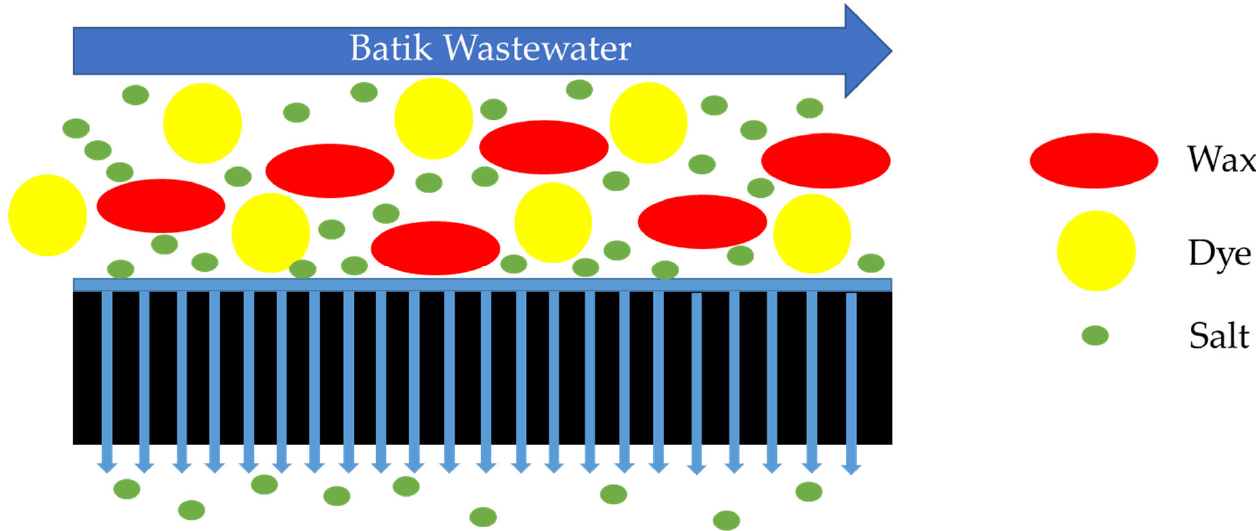
Figure 3. Illustration of contaminants separation from batik wastewater using membrane filtration (modified from [33]).